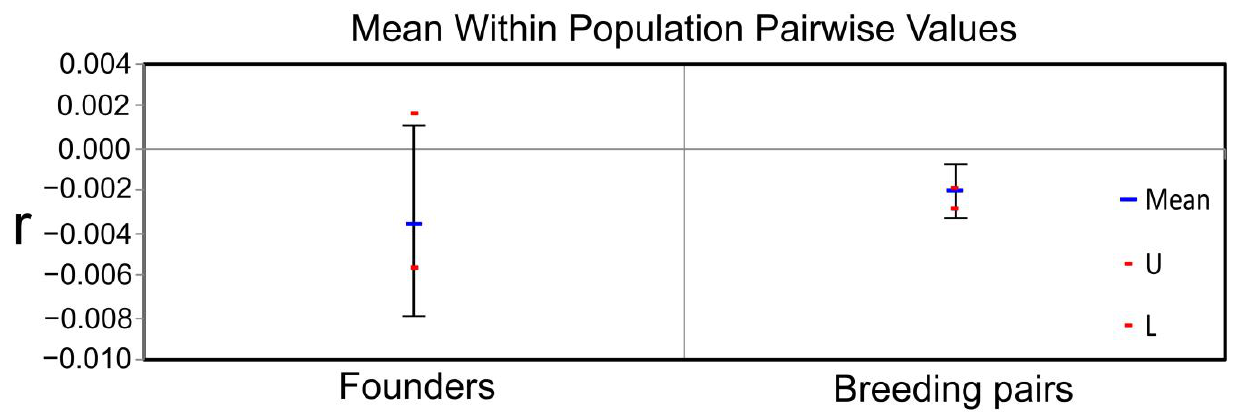
Figure 4. Ritland ’s relatedness (r) index of the Xcaret Mesoamerican scarlet macaw (Ara macao cy- Figure 4. Ritland’s relatedness (r) index of the Xcaret Mesoamerican scarlet macaw ( Ara macao anoptera) in founders and in breeding pairs groups. cyanoptera ) in founders and in breeding pairs